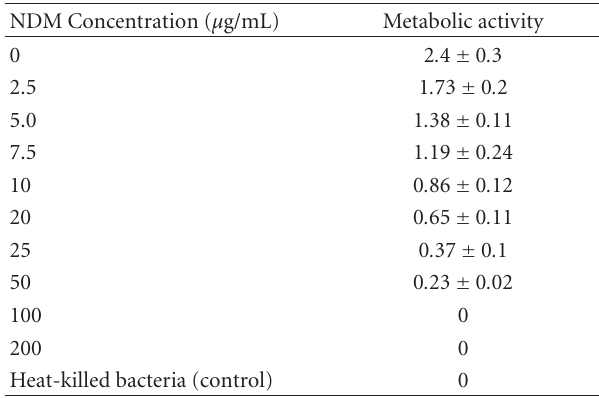
Table 1: E ff ect of cranberry NDM on the metabolic activity of S. gordonii growing in culture media measured by XTT